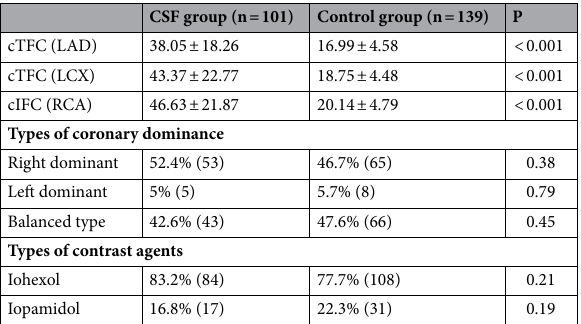
CSF group (n = 101) Control group (n = 139)